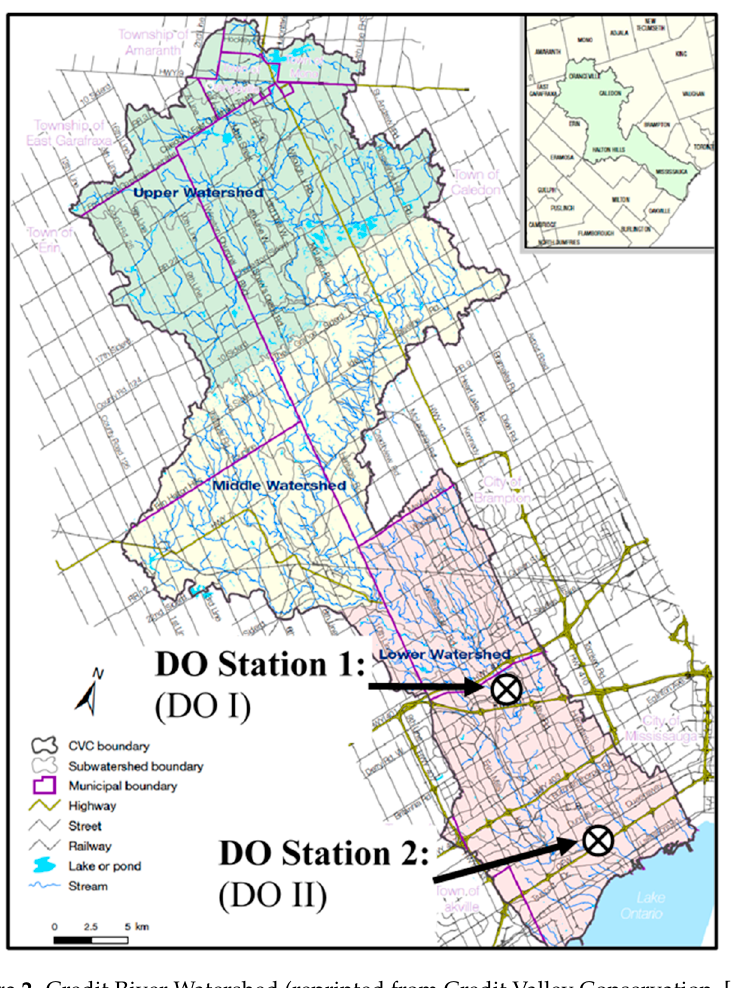
Figure 2. Credit River Watershed (reprinted from Credit Valley Conservation, [39]).